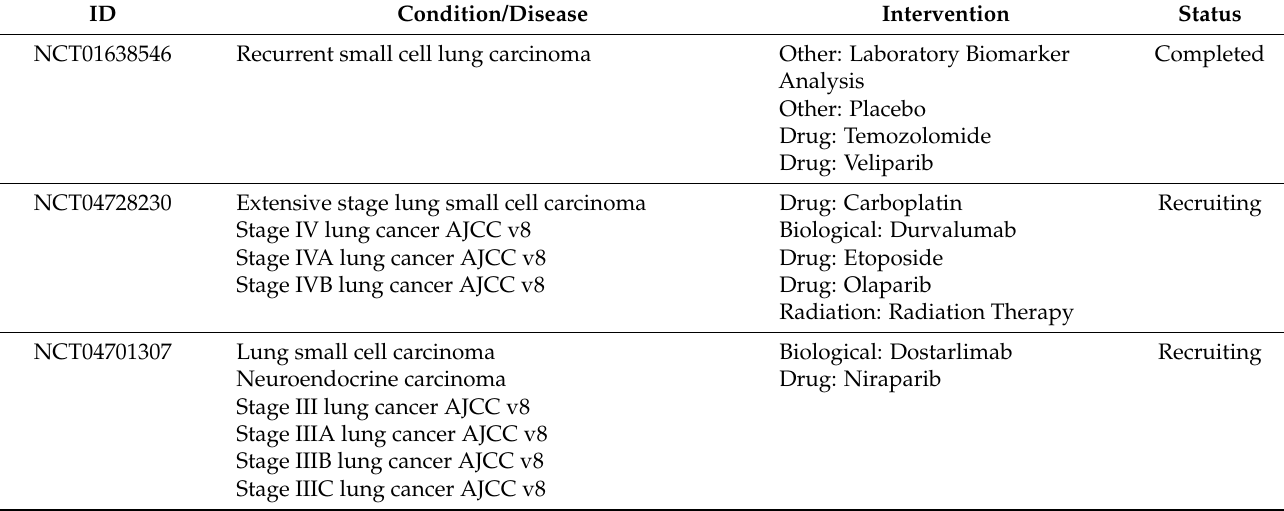
Table 2. The current clinical trials of PARP inhibitors as monotherapies or in combination with other chemotherapeutic drugs for the treatment of SCLS and